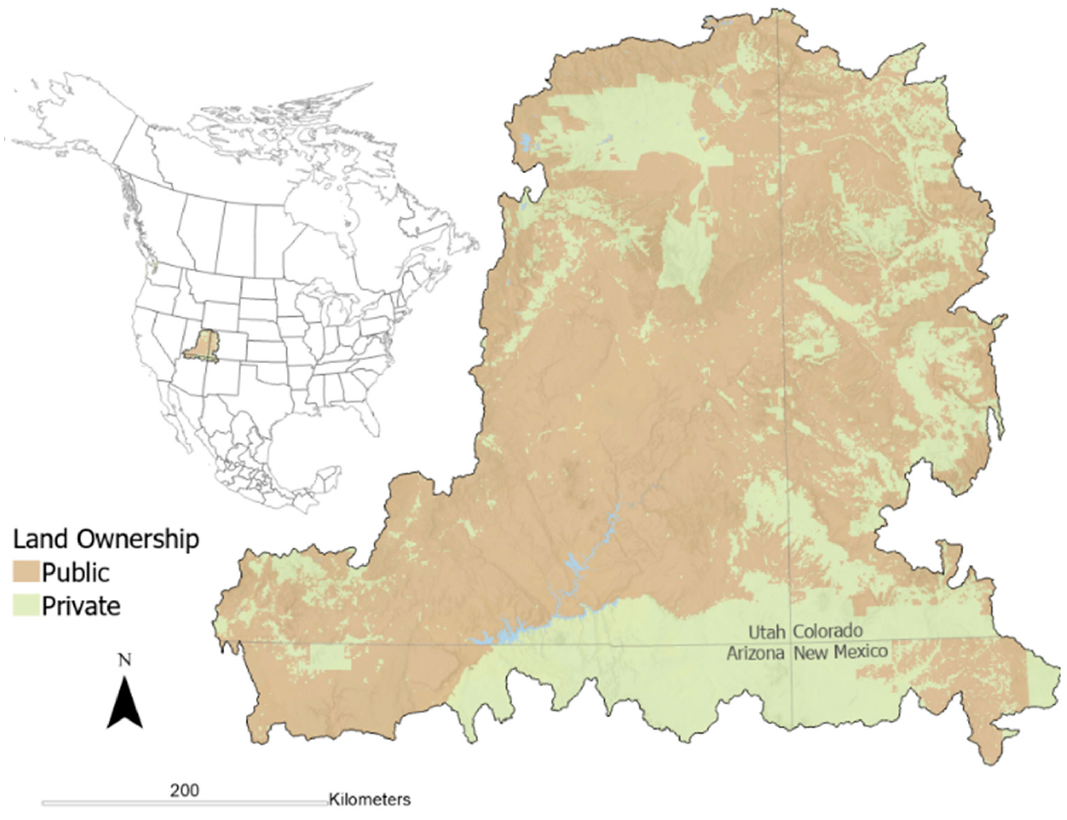
Figure 1. The Colorado Plateau and associated land tenures. Public ownership represents state and federal lands while private ownership represents local governments, NGOs, and tribal lands.